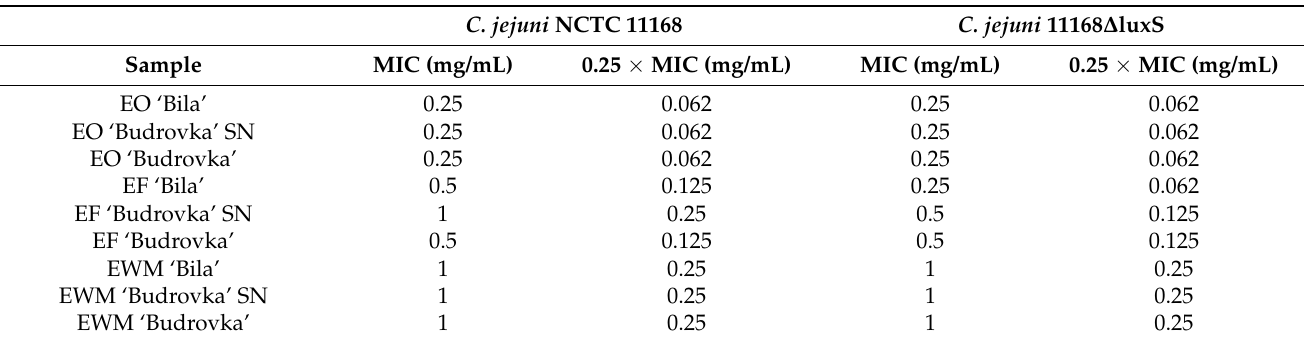
Table 3. Minimal inhibitory and subinhibitory concentration determined against C. jejuni NCTC 11168 and C. jejuni 11168 ∆ luxS for the lavandin formulations (EOs, EFs and